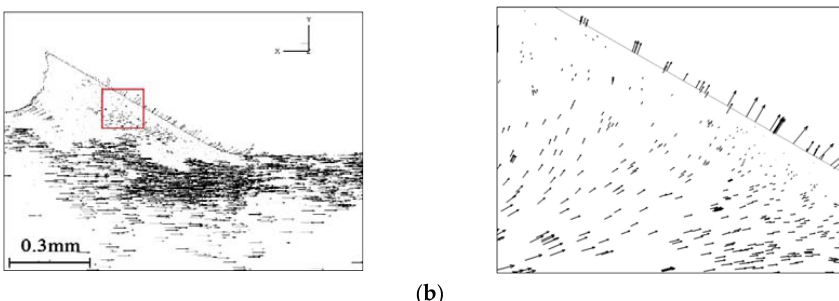
Figure 11. The material flow and accumulation (length of scratch = 6 mm). ( a ) Partial view; ( b ) Longitudinal section view.